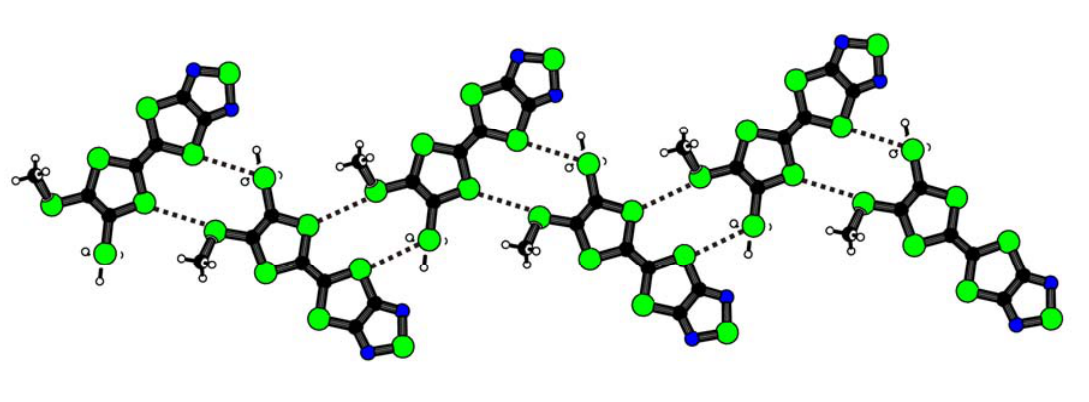
Figure 7. The one-dimensional molecular tape structure in the crystal structure of 1 . Dotted lines show intermolecular S···S heteroatom